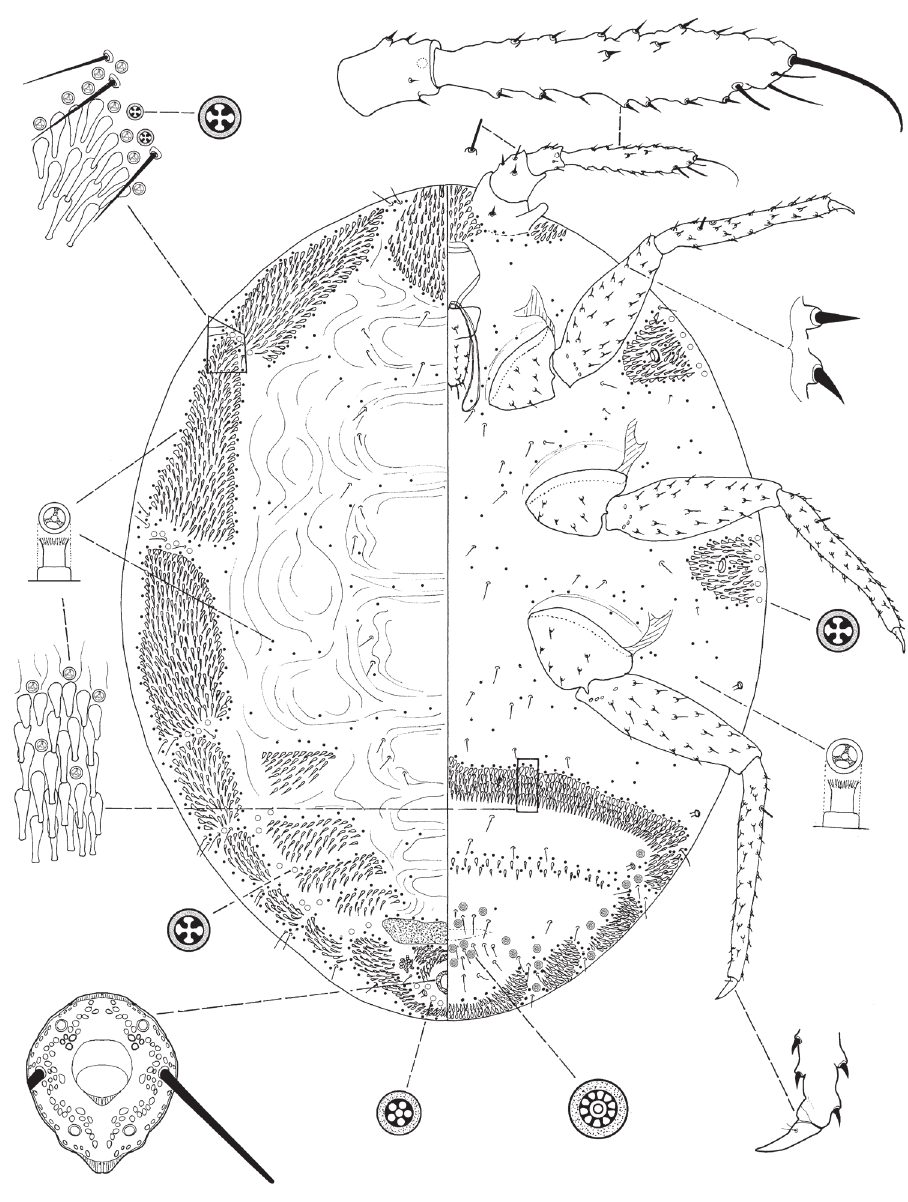
Figure 3. Ortheziola viti Szita & Konczné Benedicty sp. n., holotype, adult female. spine band, also scattered around vulva and near ovisac band, almost forming a row on the apical abdominal segment. Abdominal spiracles present with 2 pairs on each side of body anterior of ovisac band and one pair inside ovisac band, near anterolateral angle; each abdominal spiracle with sclerotized